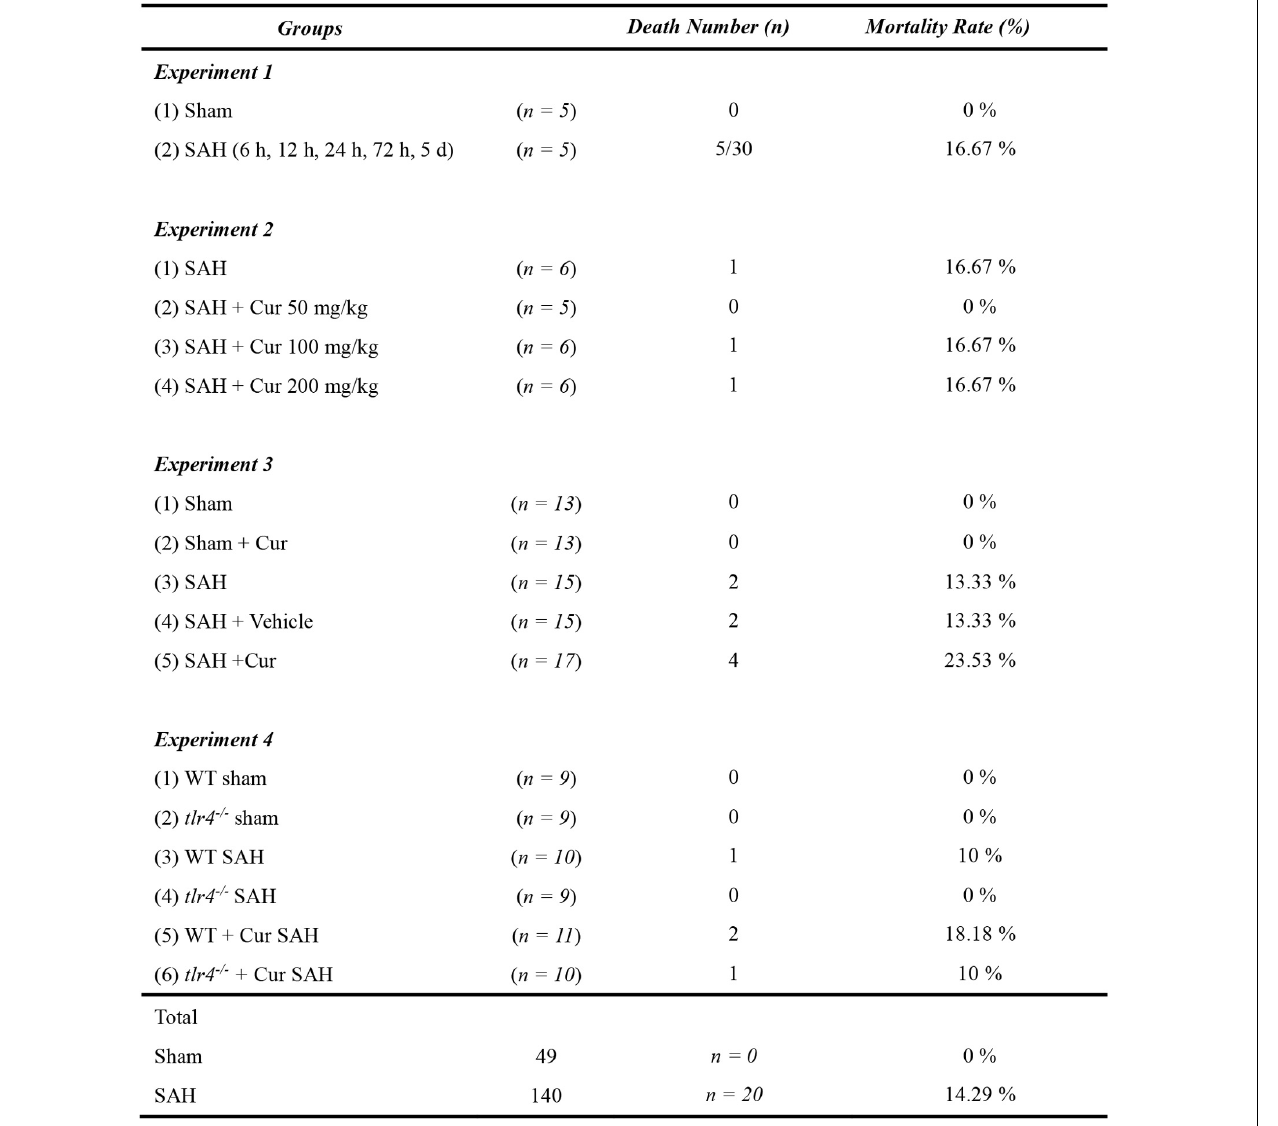
FIGURE 2 | Mortality rate following SAH in